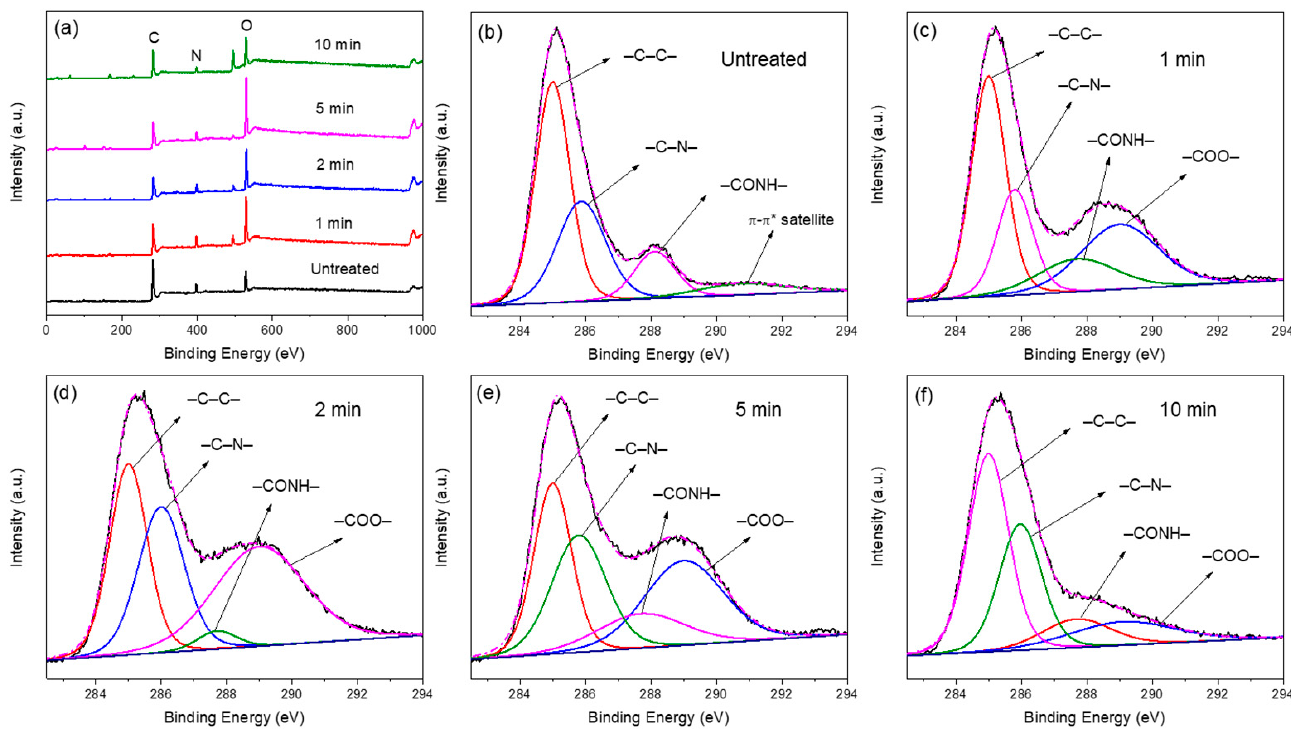
Figure 7. XPS spectra of ( a ) PPTA fabrics with different plasma treatment times. Deconvoluted C1s peaks of ( b ) untreated PPTA and PPTA treated for ( c ) 1 min, ( d ) 2 min, ( e ) 5 min, and ( f ) 10 min. Table 1. Surface chemical composition and functional groups of PPTA fabrics oxygen plasma treated at different times based on the XPS deconvoluted C1s peaks.